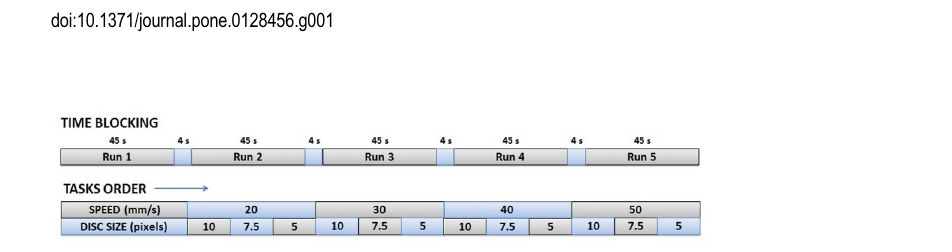
Fig 2. Blocking structure of the experimental procedure. Time blocking (up) and tasks order